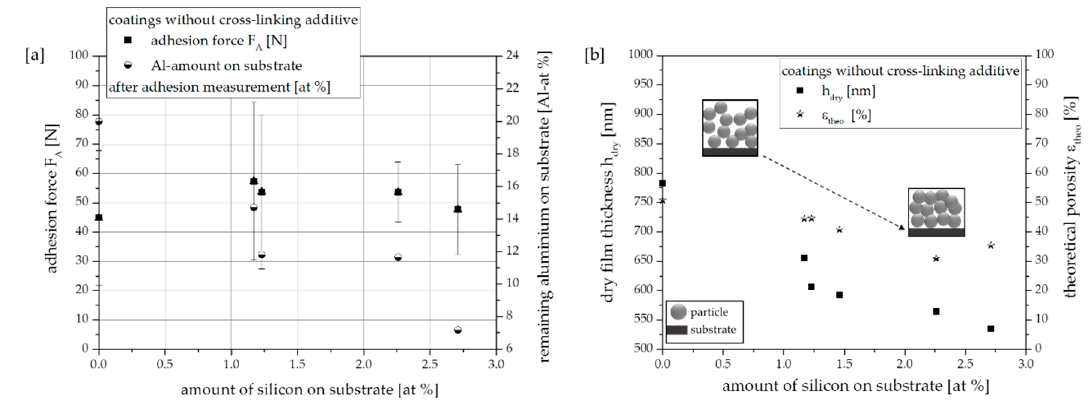
Figure 4. Coatings without cross-linking additive: measured adhesion forces and remaining aluminium on the substrate ( a ); dry film thickness and theoretical porosity ( b ).